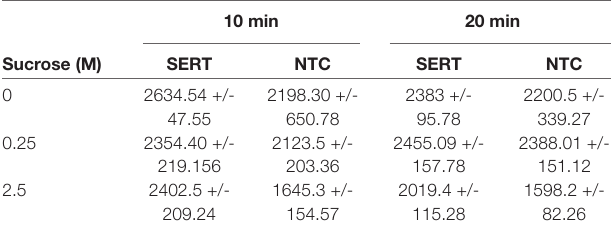
TABLE 1 | Radioactive Assay for hSERT from repetitive batch Synthesis with subsequent microsome washing.